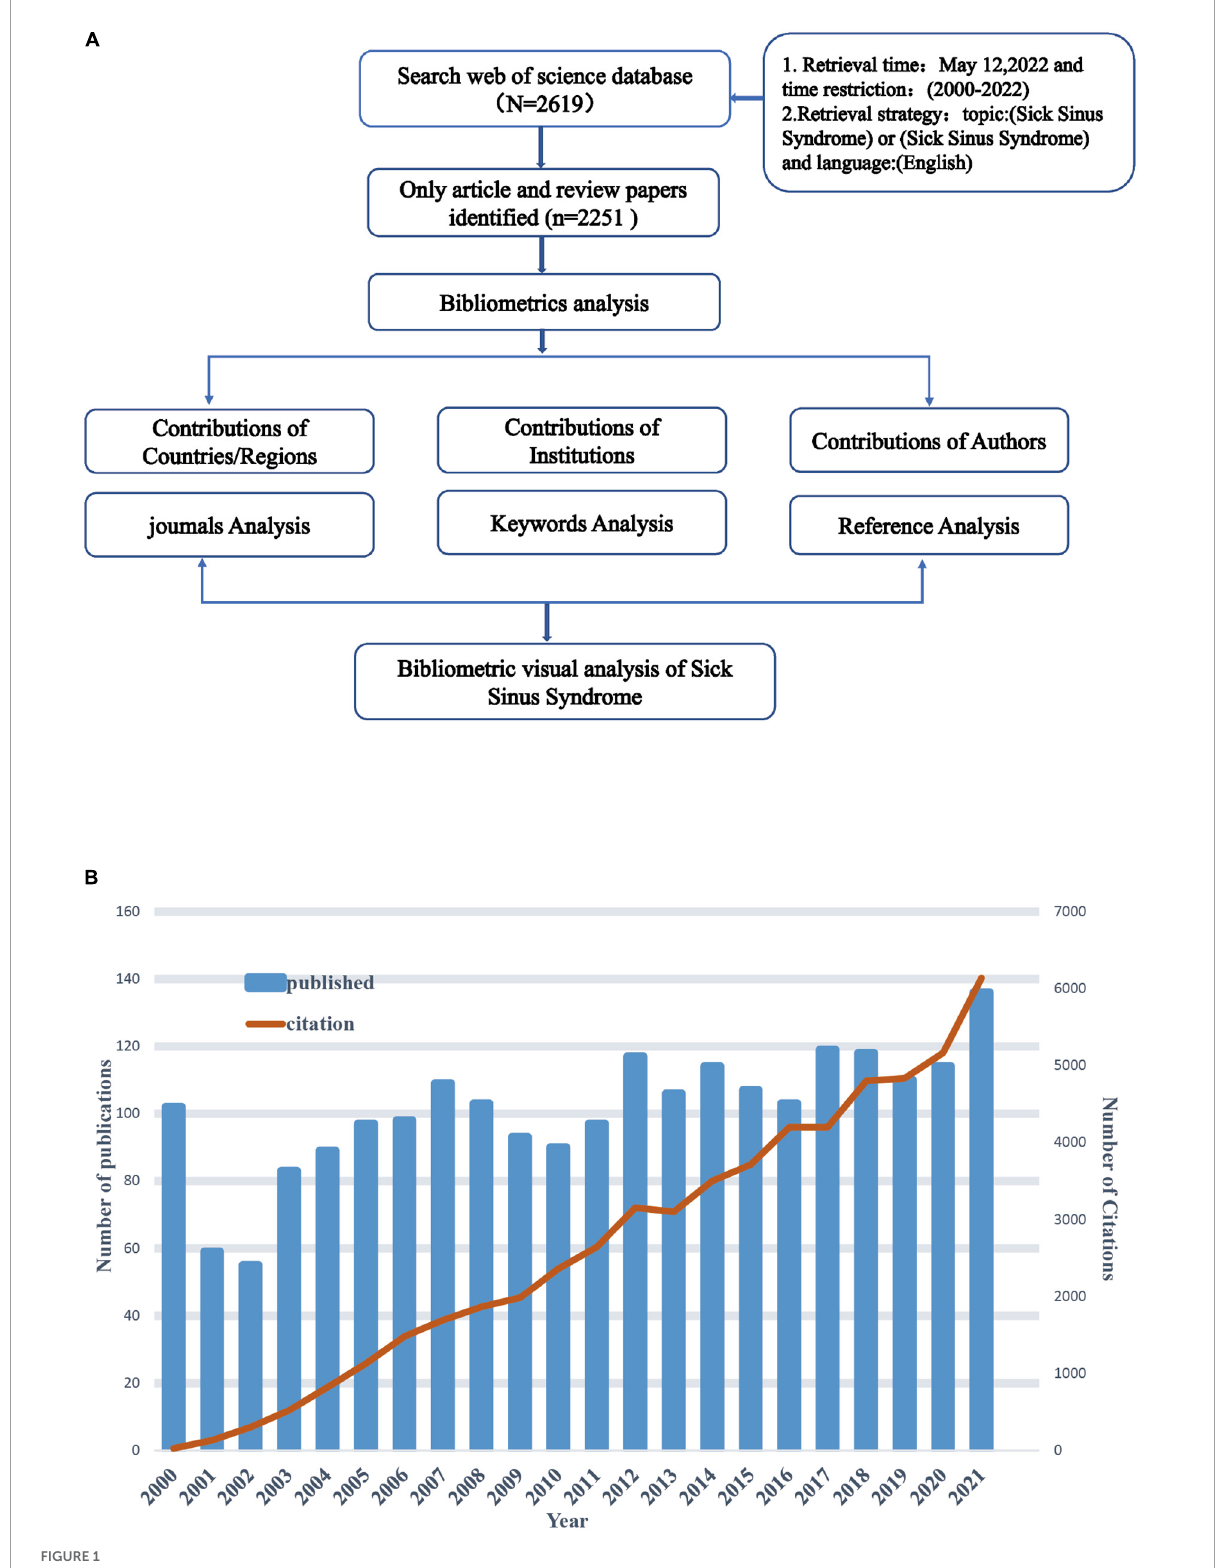
FIGURE1 (A) Flow chart of literature retrieval of sick sinus syndrome (SSS) research. (B) Global trend chart of annual publications and citations related to SSS research from 2000 to